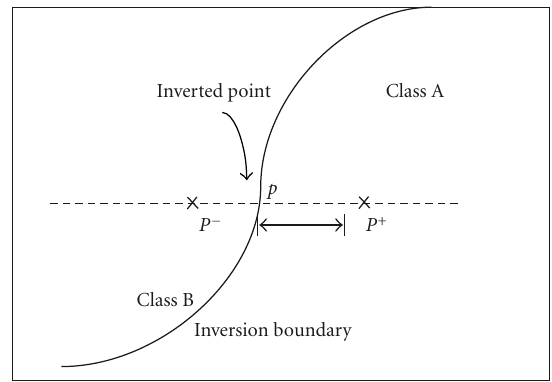
Figure 2: Conjugate data